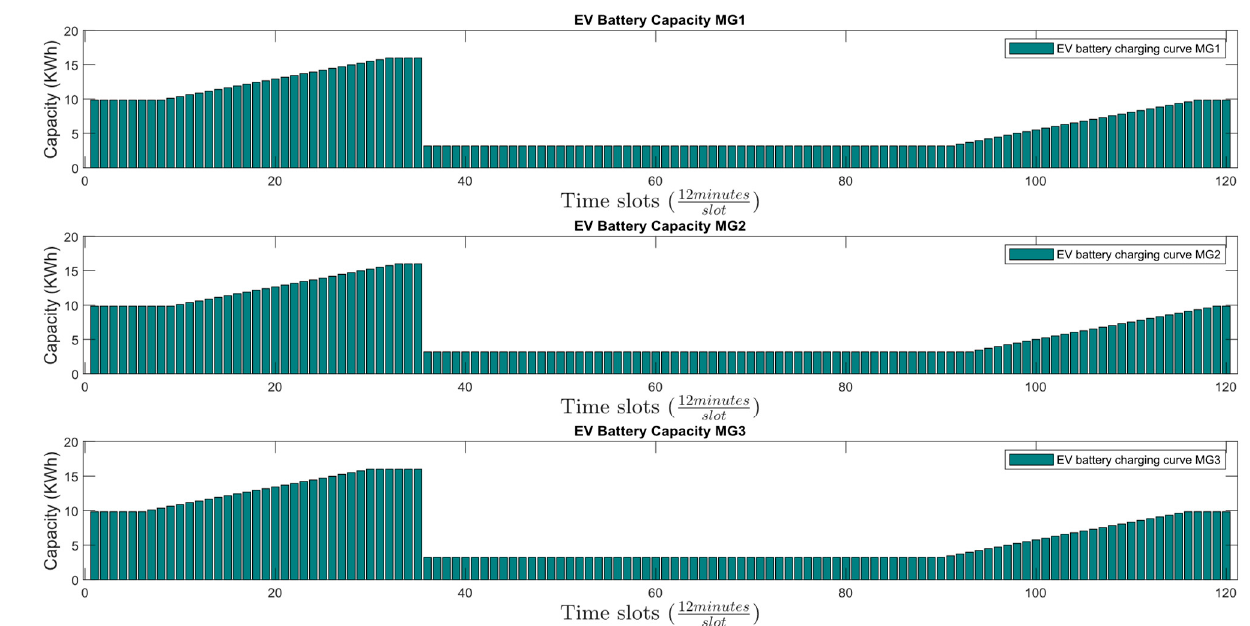
Figure 9. EV battery capacity curve of MG 1 , MG 2 , and MG 3 .